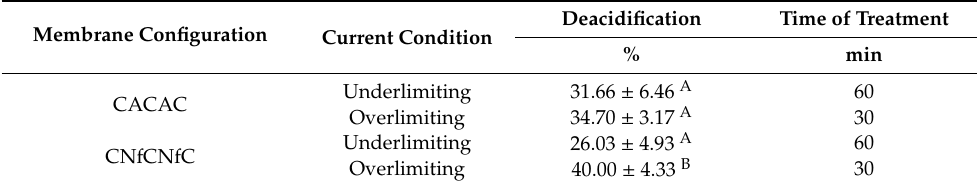
Table 2. Deacidification rate of acid whey during ED for all configurations and current conditions tested. Membrane